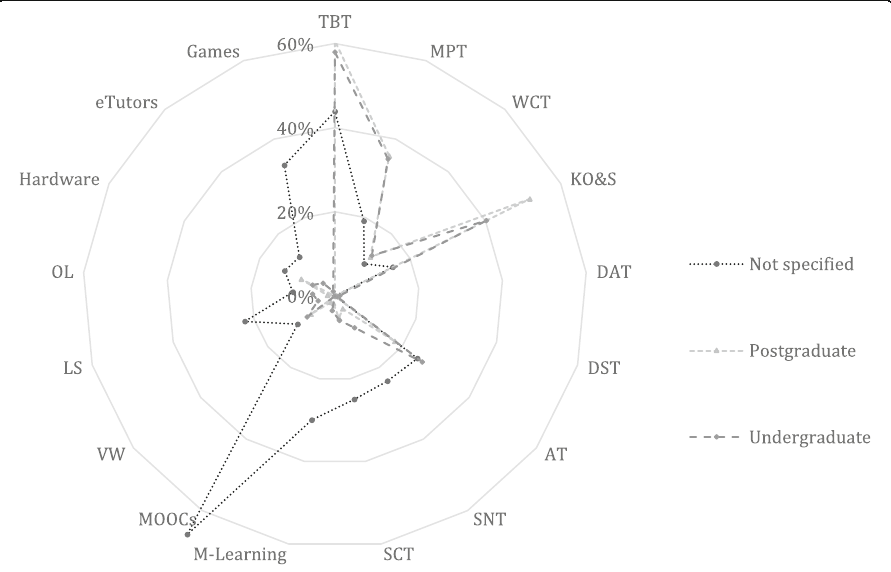
Fig. 8 Relative frequency of educational technology tools used according to study level Note. Abbreviations are explained in Fig.